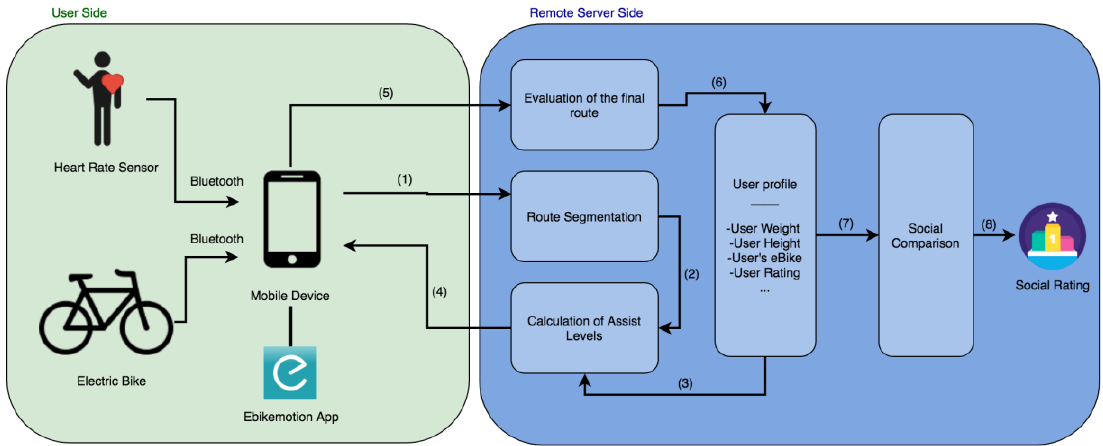
Figure 1. Overall architecture of the system: ( 1 ) the route selected by the user; ( 2 ) segmented route; ( 3 ) user profile data; ( 4 ) calculated assist levels; ( 5 ) data collected over the course of the route; ( 6 ) score obtained on the route; ( 7 ) comparison of the scores of other users; and ( 8 ) final social rating.